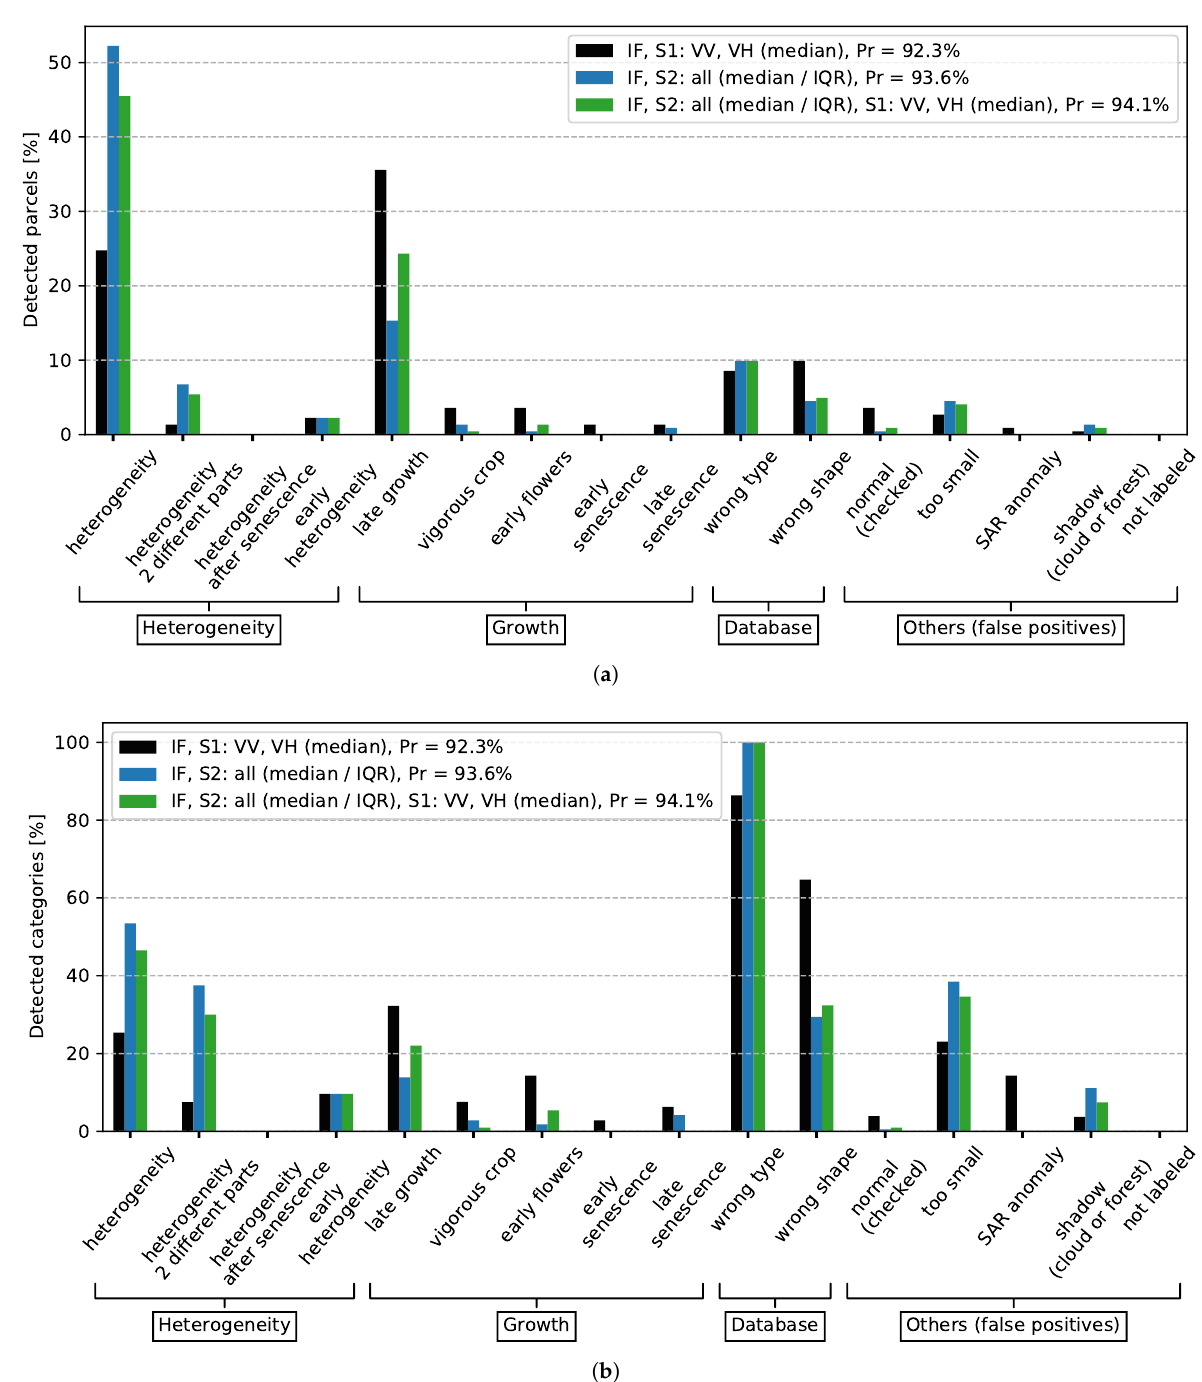
Figure 13. ( a ) 100 × (Number of detected parcels in each category/Number of detected parcels) ( b ) 100 × (Number of detected parcels in each category/Number of parcels in each category). The analysis is conducted using rapeseed parcels with an outlier ratio equal to 10% and the IF algorithm. Black: S1 features only, blue: S2 features only, green: S1 and S2 features jointly. The precision (Pr) of the results for each feature set is added in the